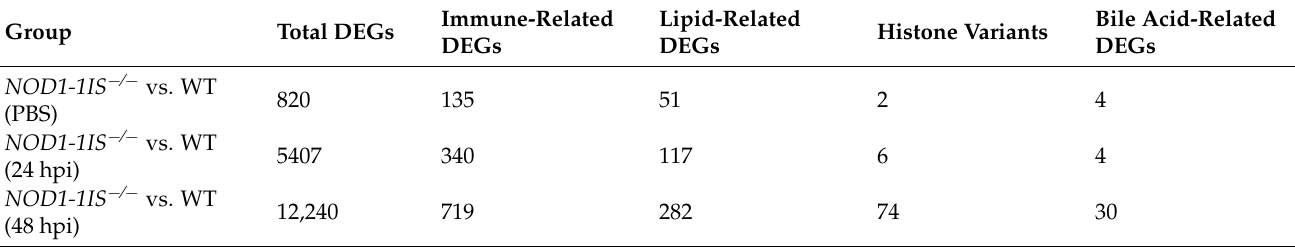
Bile Acid-Related Immune-Related Lipid-Related Histone Variants DEGs DEGs DEGs